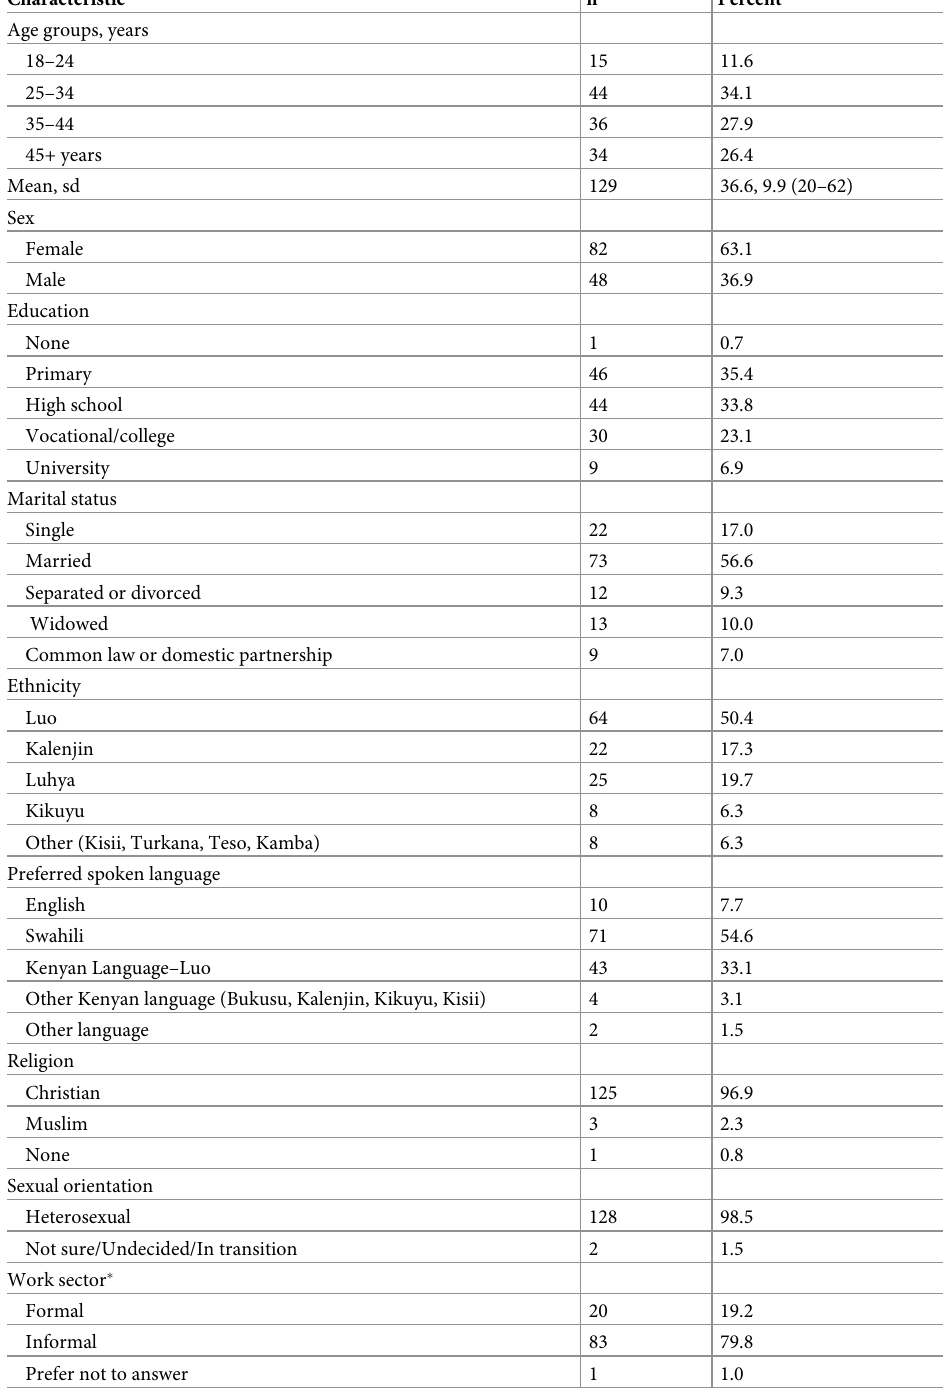
Table 2. Demographic Characteristics of Networks participants, n =